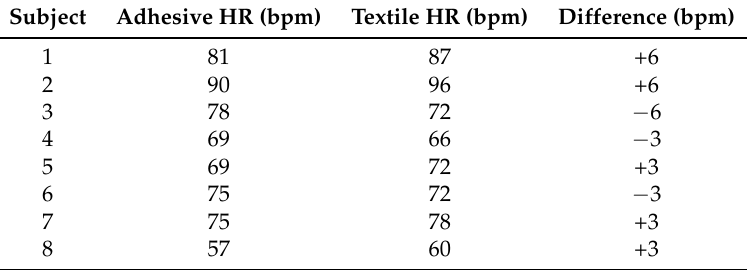
Table 2. Heart rate (HR) for textile and adhesive electrodes for each subject.